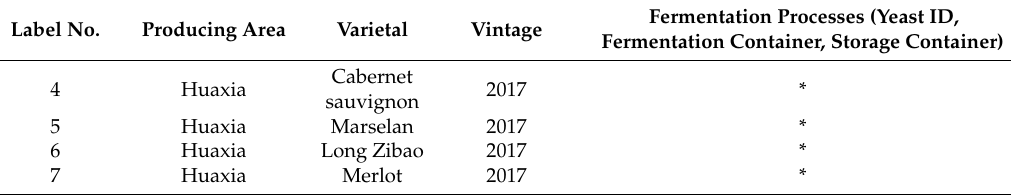
Table 3. Details of wine samples with different varietal.